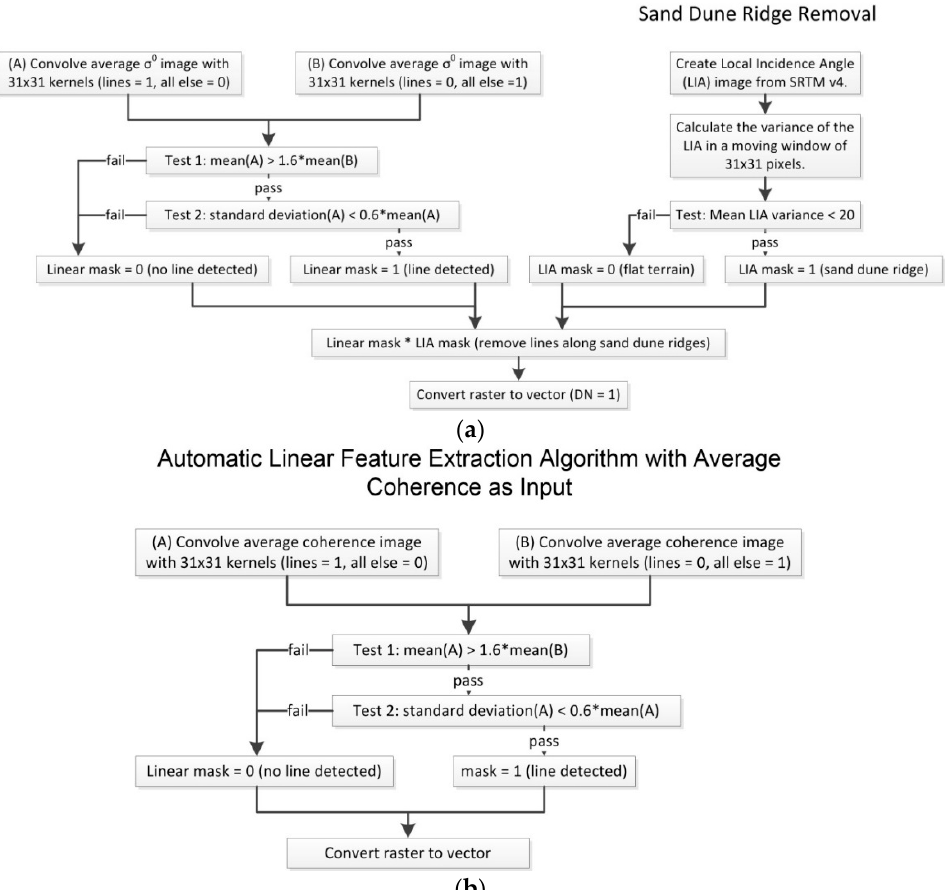
Figure 4. ( a ) Linear feature detection algorithm with PALSAR-1 average, De Grandi filtered σ ° as input and with local incidence angle mask from SRTM DEM; ( b ) Linear feature detection algorithm with PALSAR-1 average coherence as input. With the average coherence as input there is no longer a need for the local incidence angle mask to remove sand dune ridges.